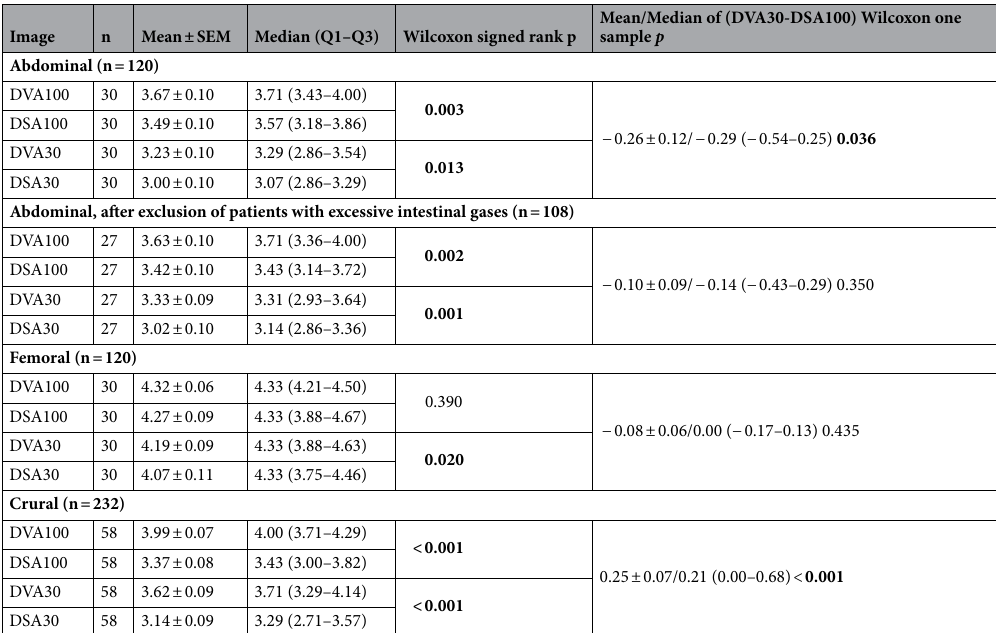
Table 3. Visual evaluation results. Readers evaluated in total 472 images by using a 5-grade Likert scale: ranging from poor (1) to outstanding (5) image quality (for details see The Materials and Methods section). Values are expressed as the mean ± SEM, and the median and the interquartile range (Q1–Q3). Data were analysed by the Wilcoxon signed rank test (DVA vs DSA) or the Wilcoxon one sample test (non-inferiority analysis between DVA30 and DSA100). Bold: significant difference, p < 0.05. DVA: Digital Variance Angiography, DSA: Digital Subtraction Angiography. The index defines the applied protocol, 100: normal dose, 30: low-dose. SEM: Standard Error of